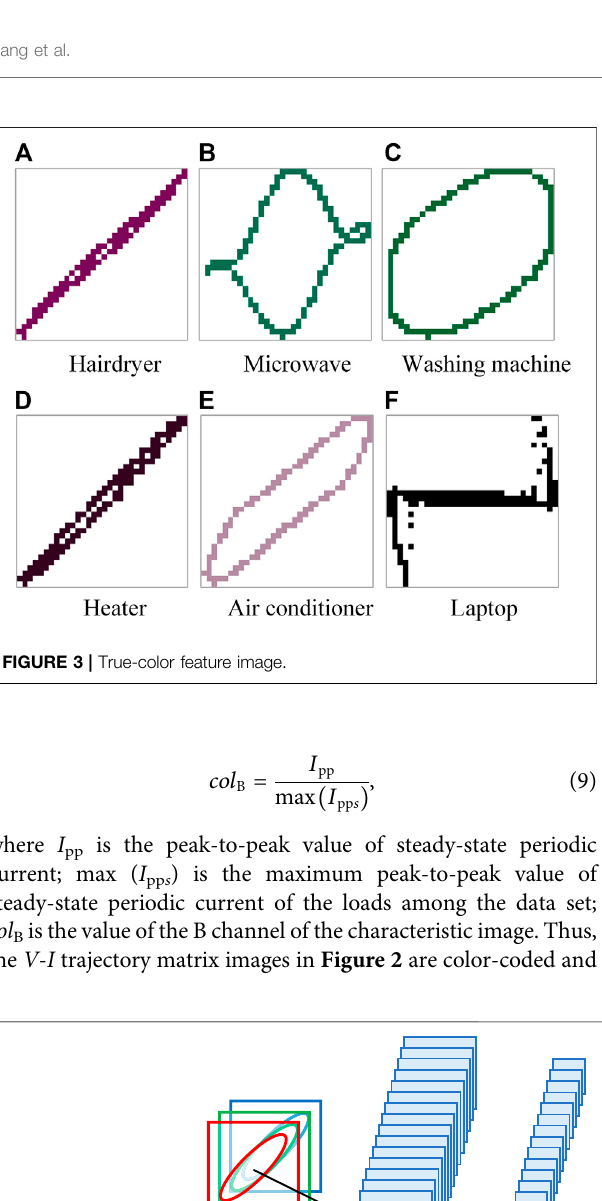
FIGURE 4 | CNN framework.